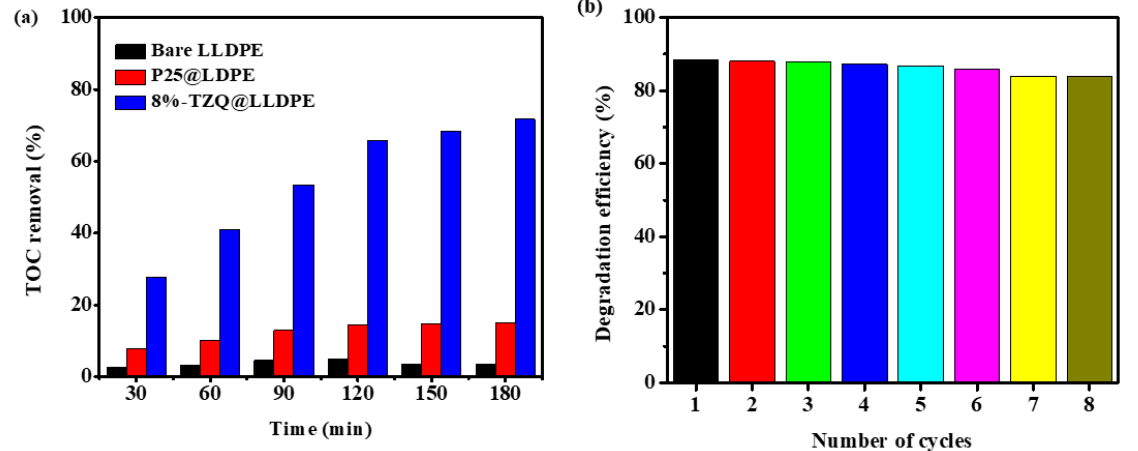
Figure 11. ( a ) Photocatalytic mineralisation of TC in the presence of bare LLDPE and LLDPE hybrid films, and ( b ) recycle experiment for the photodegradation of TC using 8%-ZT@LLDPE.